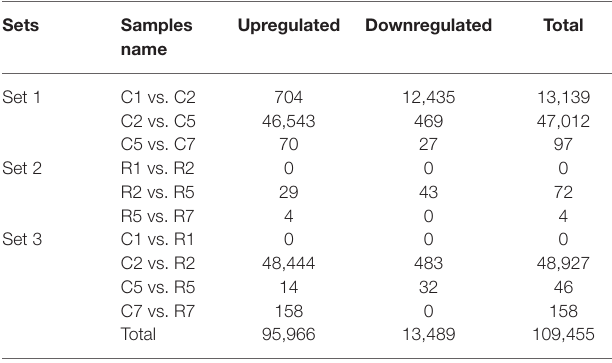
TABLE 1 | Detailed list of differentially expressed genes obtained in all the three